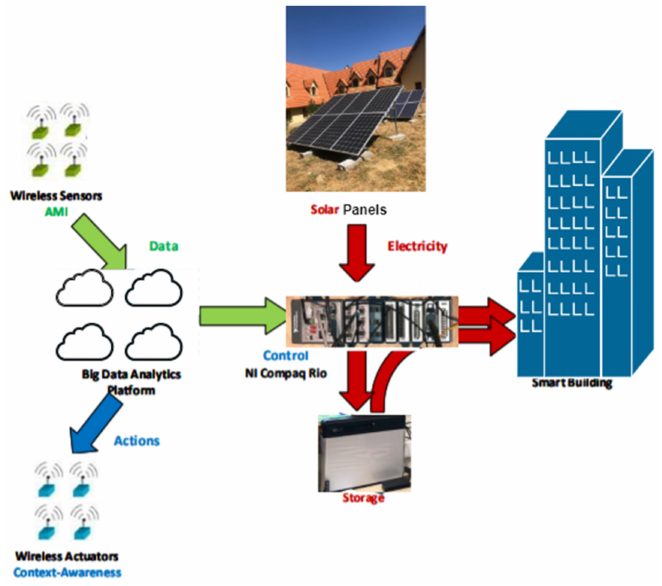
Figure 4. MiGrid general